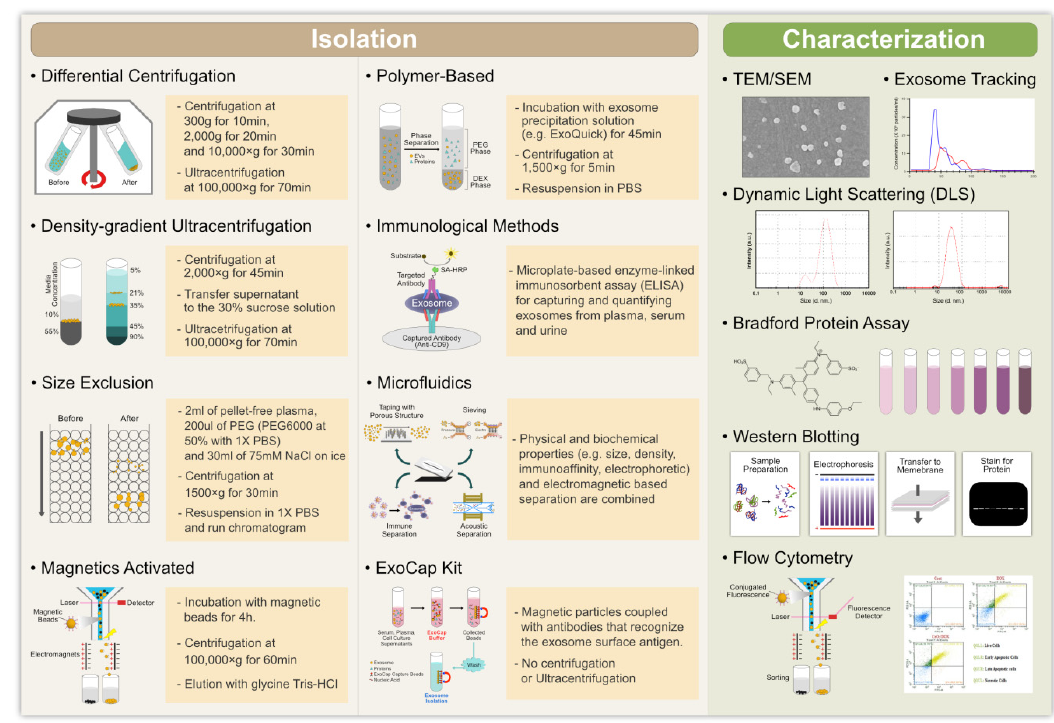
Figure 4. Various techniques used for isolation, characterization, and analysis of functional properties of exosomes.